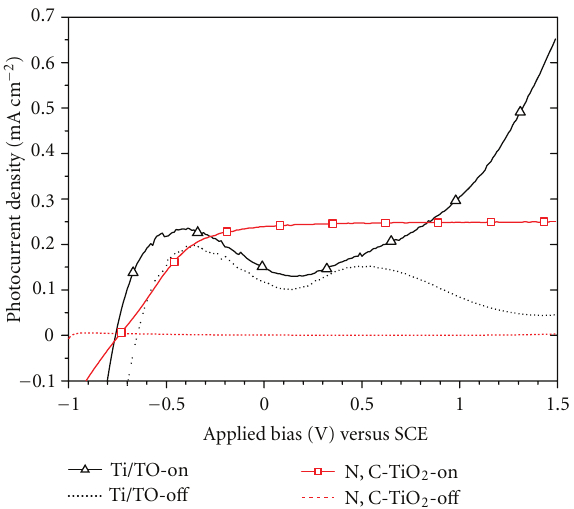
Figure 7: Photocurrent response of the Ti/TO and N,C-TiO 2 electrodes in Na 2 CO 3 mixed with DMSO aqueous